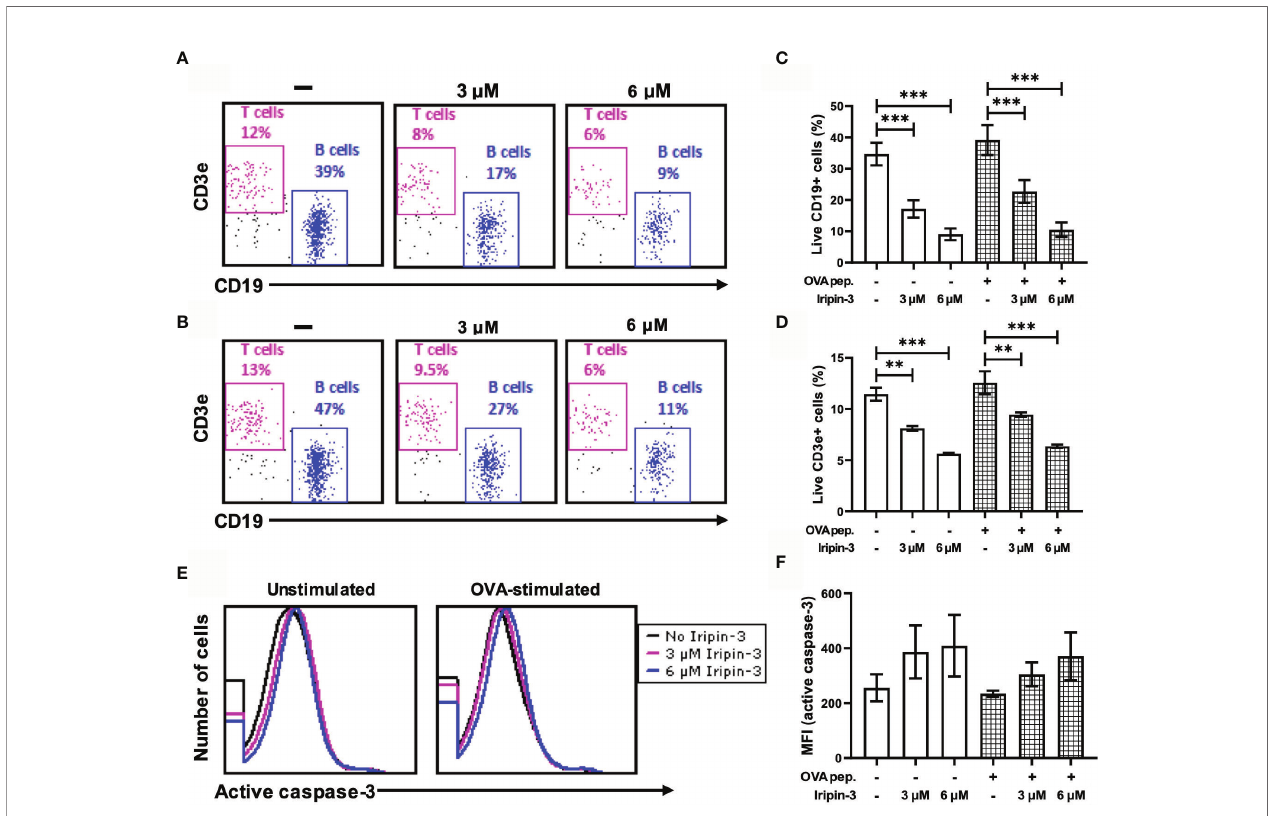
FIGURE 8 | Iripin-3 reduces B and T cell viability and does not signi fi cantly alter active caspase-3 levels. (A, B) Dot plots depicting the percentage of live CD45 + CD19 + cells (B cells) and live CD45 + CD3e + cells (T cells) in unstimulated splenocytes (A) or OVA peptide-stimulated splenocytes (B) . Splenocytes were not treated with Iripin-3 (left) or were treated with 3 m M (middle) or 6 m M (right) Iripin-3. (C, D, F) The percentage of live B cells (C) , live T cells (D) , and median fl uorescence intensity (MFI) corresponding to the level of active caspase-3 (F) after incubating the splenocytes for 20 h in the absence of Iripin-3 or in the presence of 3 m M and 6 m M Iripin-3. The cells were left either unstimulated or were stimulated with 100 ng/ml of OVA peptide. Data are presented as mean ± SEM of three independent experiments (**p < 0.01, ***p < 0.001). (E) Histograms showing the level of active caspase-3 in either unstimulated splenocytes (left) or splenocytes stimulated with OVA peptide (right). Splenocytes were incubated for 20 h without Iripin-3 or were treated with 3 m M or 6 m M